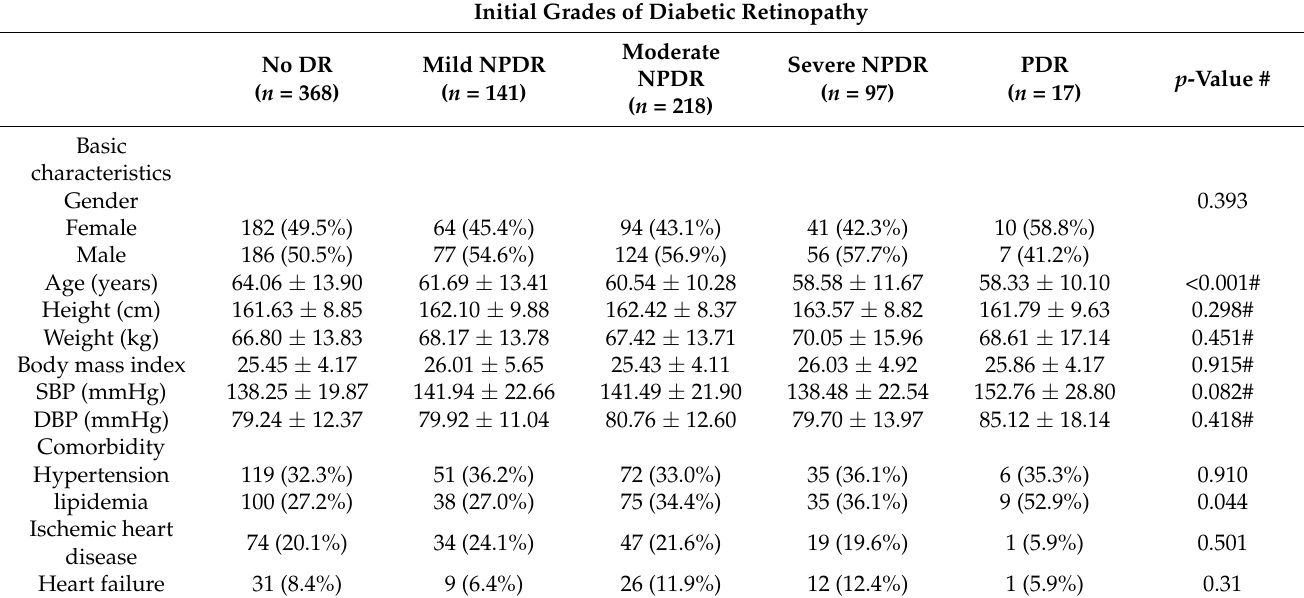
Table 4. The characteristics of non-CKD group patients at enrollment with different initial grades of diabetic